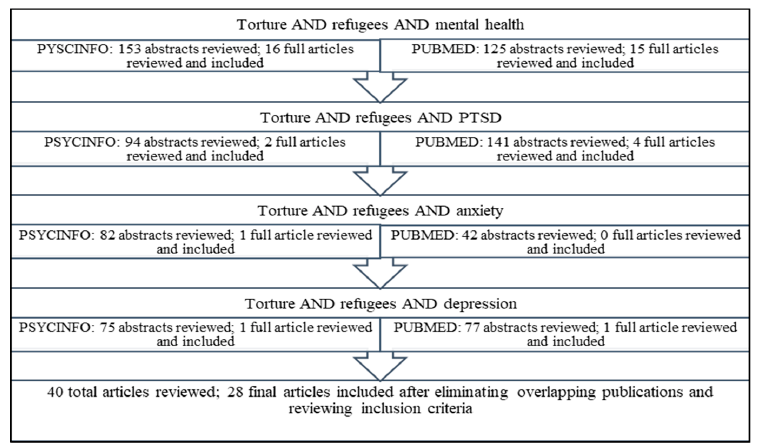
Figure 1. Selection method for research articles to review.